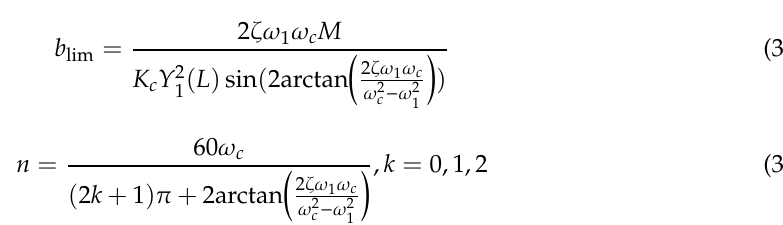
Figure 6. Natural frequencies of these two models for different composite materials.